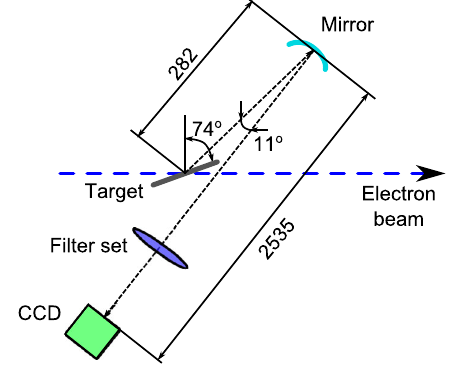
FIG. 6. Scheme of the beam imaging experiment setup.